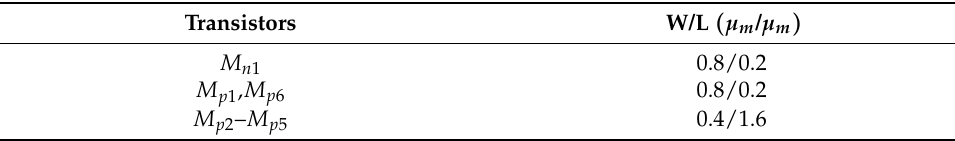
Figure 8. The circuit used to implement the switch cell is presented. This is a compact gate with only 6 transistors. For inputs Y 1 = Y 2 = 300 mV, RBF’s current I bias flows through M p 5 as I y , while for Table 3. Switch’s transistor